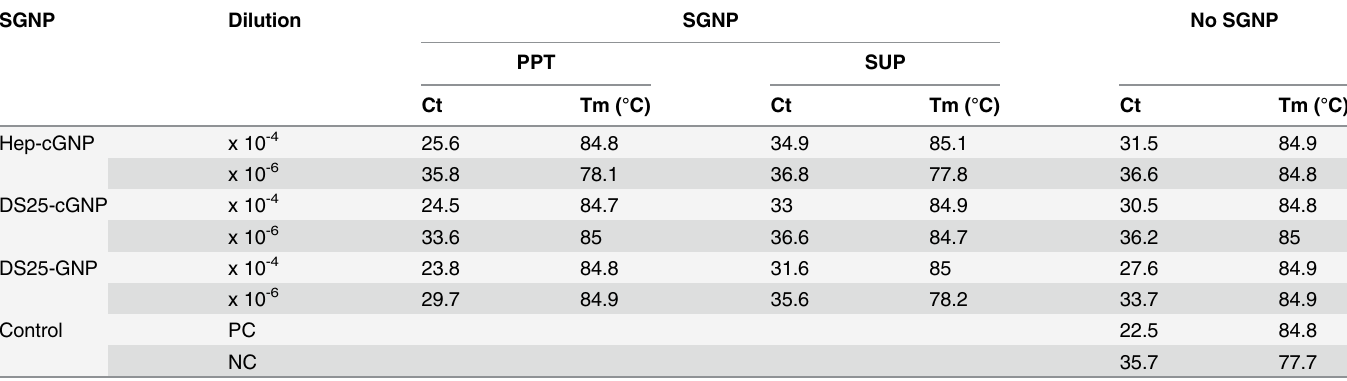
Table 1. Comparison of the SGNPs in terms of their ability to capture and concentrate dengue viruses (DENVs). SGNP